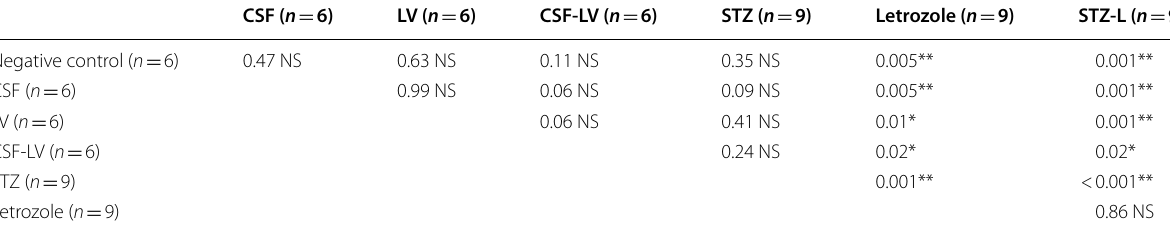
Table 3 LSD for Let‑7a fold change among different studied groups